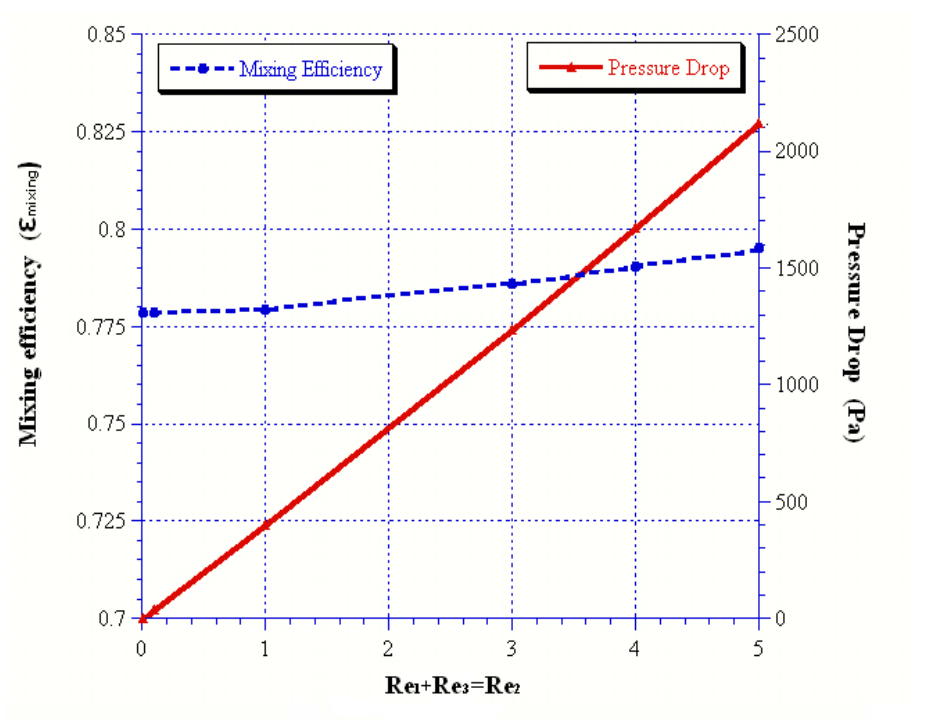
Figure 4. Reynolds number effect related to the mixing and pressure drop at Rer =